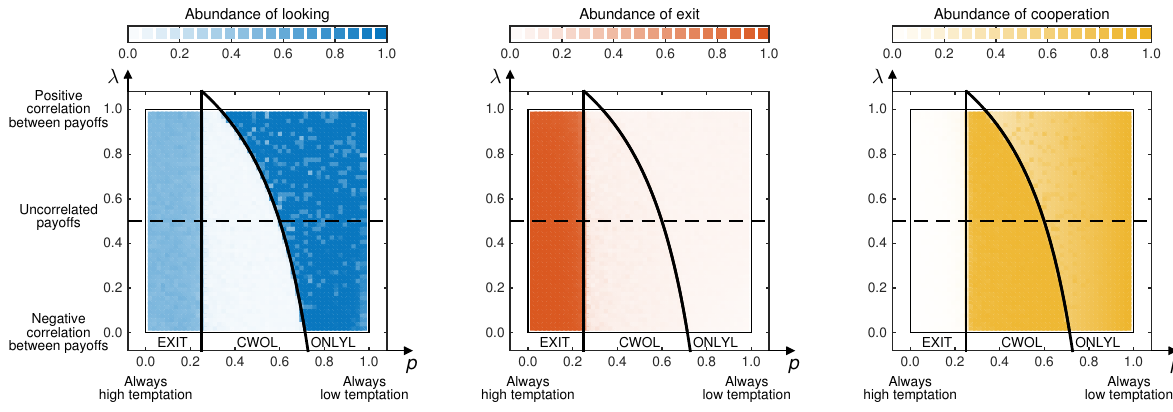
Figure 3. Results of the evolutionary simulations for various combinations of p and λ (the probability that Player 1 has a low defection payoff and the correlation parameter, respectively). The three graphs show the percentage of games in which Player 1 decides to look, in which Player 2 decides to exit and in which the interaction ends with Player 1 cooperating. To generate the contour plot, we have simulated the evolutionary process for 10 6 strategy updating events for 50 × 50 different combinations of p and λ . The depicted colors show the time average over the whole course of such a simulation. As indicated, the numerical results are in agreement with the predictions based on backward induction (the inequalities in Theorem 1 are depicted by the thick black lines). The parameters are the same as in Figure